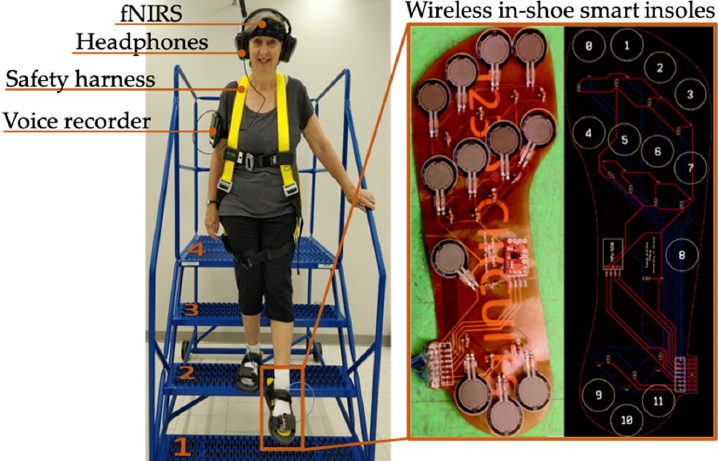
Figure 1. Example of a participant descending the stairs. Participants wore wireless in-shoe smart insoles with 12 force sensitive resistors dispersed across the forefoot, midfoot and heel (adapted from Badawi et al., 2019). The stairs were composed of four steps (25 cm riser, 30 cm tread, 91 cm width) and were located in a well-lit room. Participants also wore an fNIRS device, wireless headphones, a safety harness, and a voice recorder throughout the